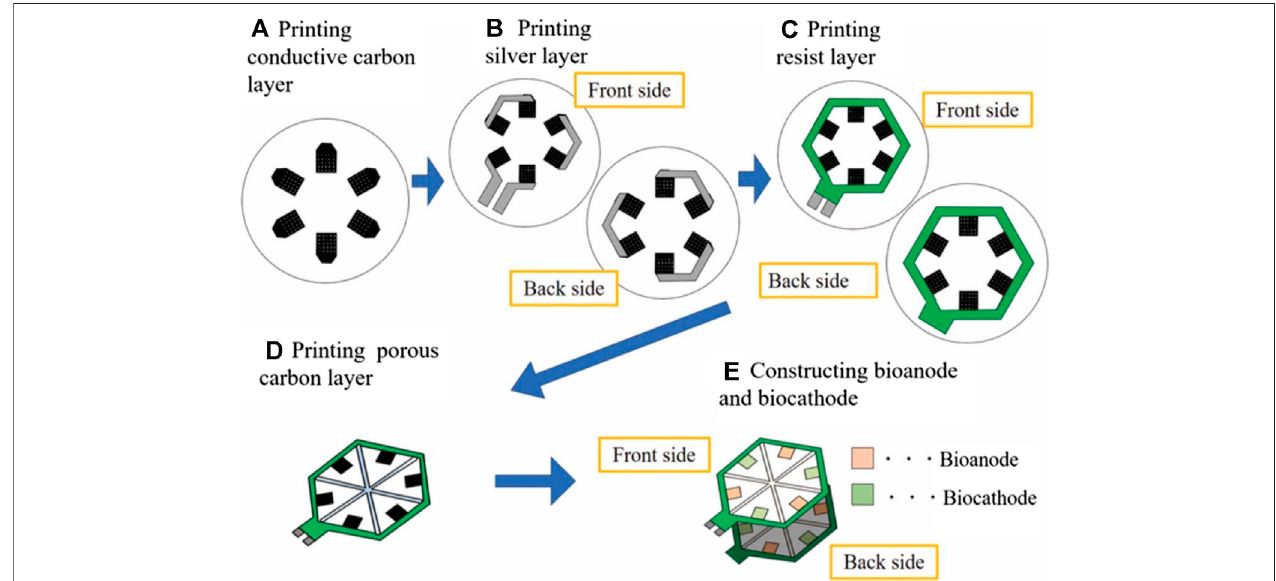
FIGURE 1 | The process of the design and fabrication for the urine glucose test paper (Shitanda et al., 2019).